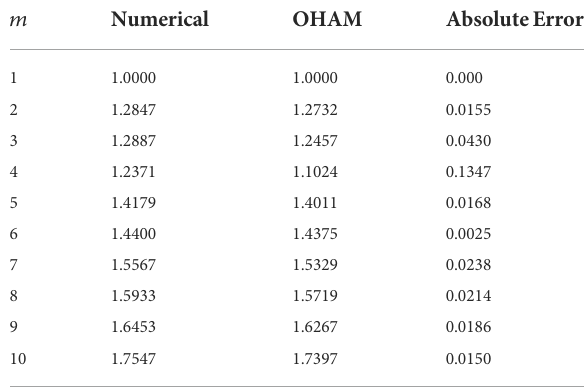
FIGURE 1 Geometry of the fl ow problem.